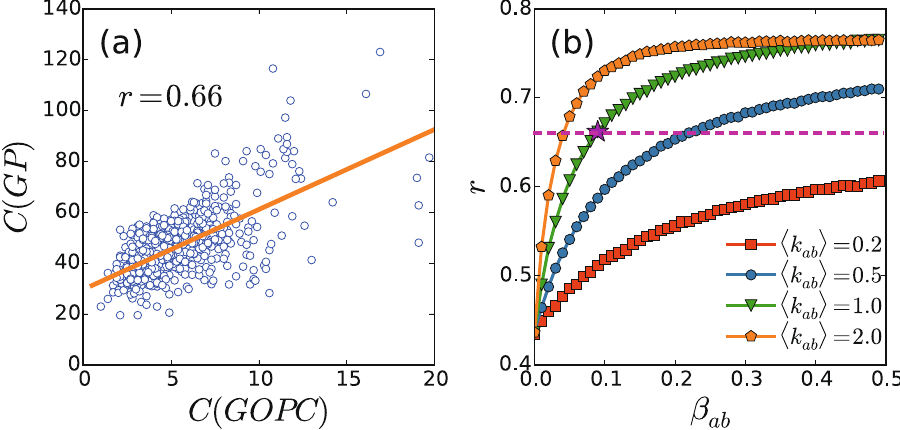
Figure 5. Correlation between the two coupled layers. ( a ) Correlation between the two time series of GOPC and GP. ( b ) Dependence of the correlation coefficient r on β ab for 〈 k ab 〉 = 0.2, 0.5, 1.0 and 2.0, respectively, where the purple “star” and its related dashed line represent the point of r = 0.66. Other parameters are the same as in Fig. 3(a) and